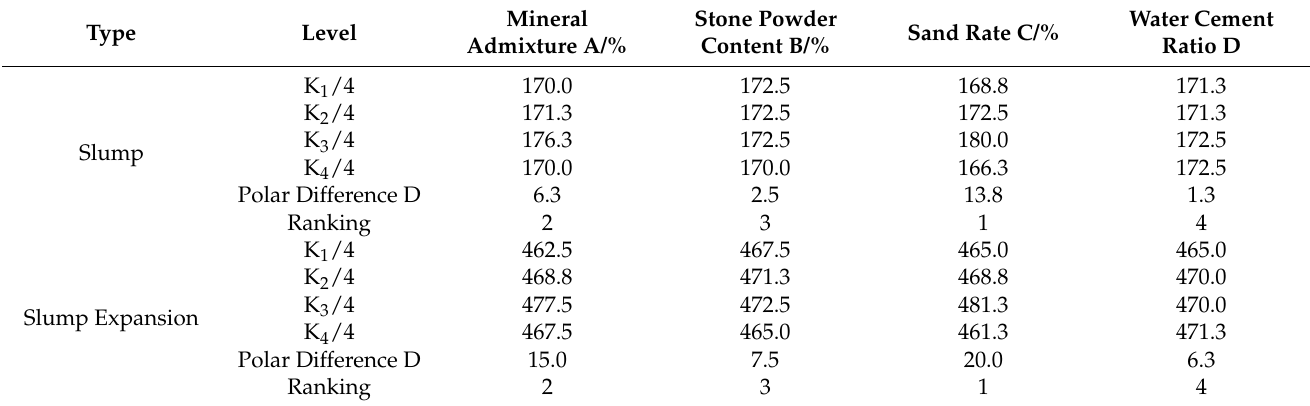
Table 7. Slump and slump expansion degree extreme difference analysis table